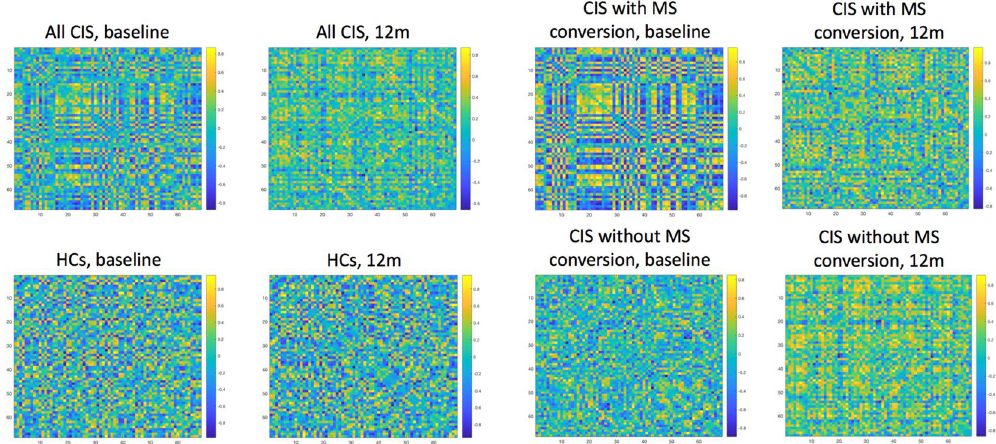
Figure 5. Correlation matrices. This figure shows the correlation matrices for each one of the groups (all CIS, HCs, CIS with early conversion, CIS without early clinical conversion), at baseline and at follow-up. From these correlation matrices, we extracted the absolute values of the correlations and built the weighted graphs, used to obtain network metrics. Abbreviations: CIS: clinically isolated syndrome; HCs: healthy controls; MS: multiple